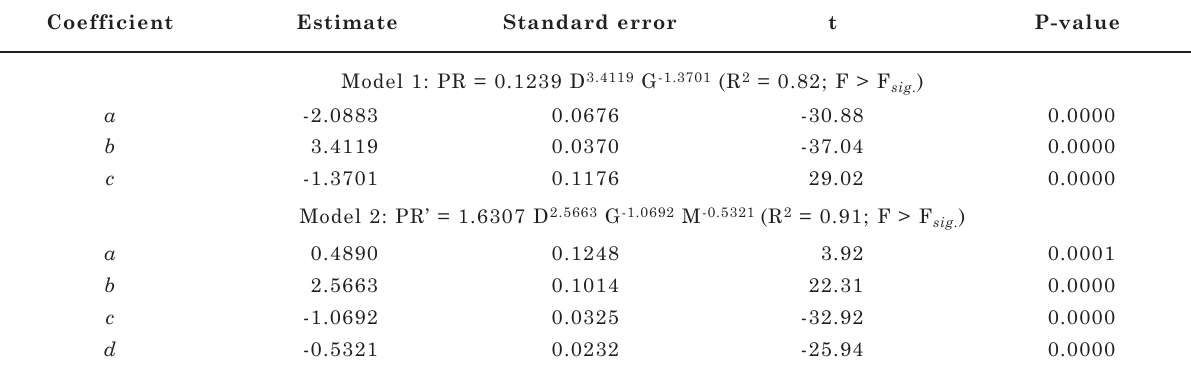
table 3. linear regression coefficient estimated for soil penetration resistance curves (lnPr = ln a + b lnd + c lng ; lnPr’ = ln a + b lnd + c lng + d lnM) for a eutroferric red oxisol under annual no-till cropping